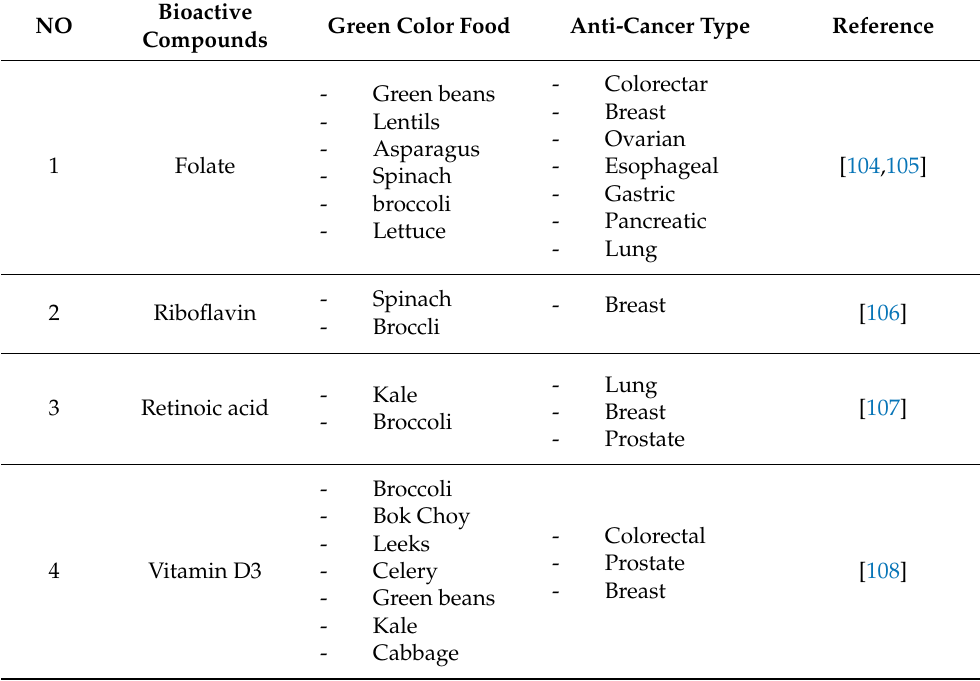
Table 2. Anti-cancer activities of other bioactive compounds-derived from green colored